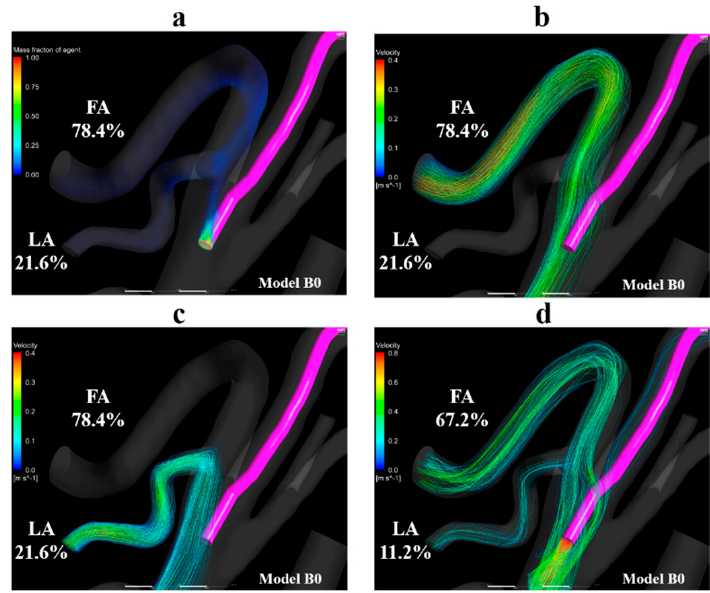
Figure 10. Volume-rendering image and streamlines in model B0. ( a ) Volume-rendering image of the mass fraction of agent in model B0 with injection condition of the syringe driver, ( b ) streamlines toward the FA in model B0, ( c ) streamlines toward the LA in model B0. ( d ) Streamlines originate from the catheter tip in model B0 with the injection condition of the syringe driver. The number of figures shows the distribution rate of the agent. FA, facial artery; LA, lingual artery.